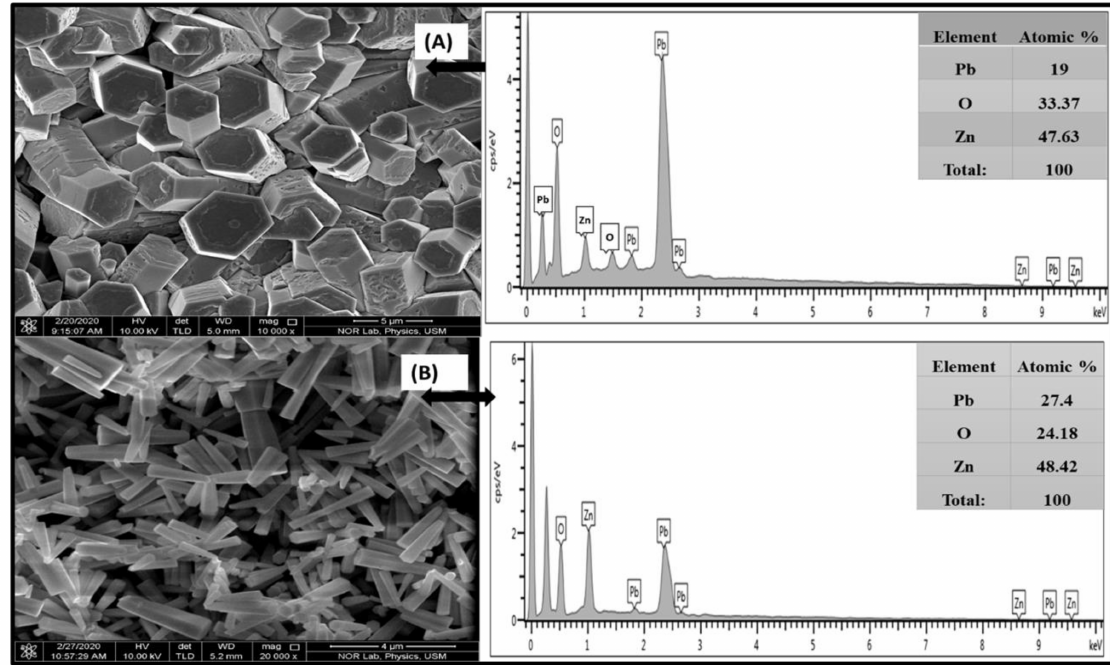
Figure 2. FESEM images of the nanostructured ZnO-Pb ( A ) thin film and ( B ) powder of the disk, and their EDX.